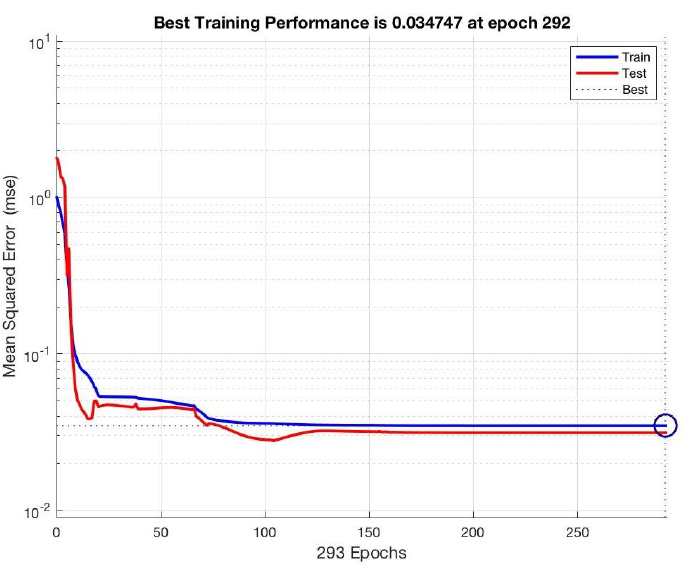
Figure 6. Learning curves of neural network for presented neural network model of the vibration generator.